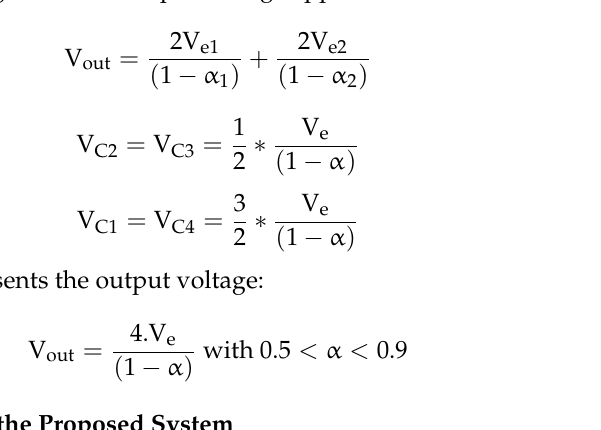
Figure 3. The electrical circuit of a DC-DC converter with high-voltage gain. The capacitor voltages and the output voltage applied are defined